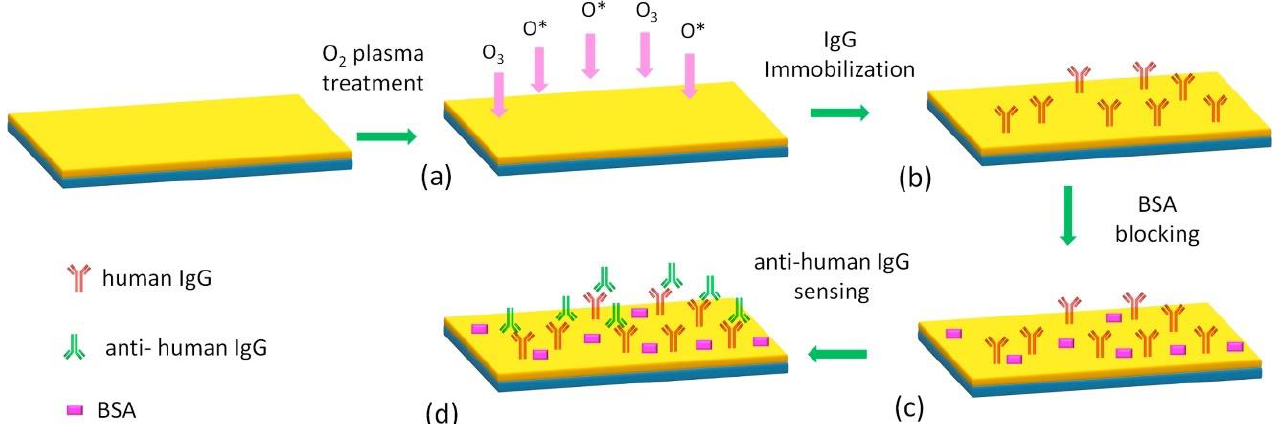
Figure 8. Schematic representation of the immobilization process of IgG on SU-8 substrate and of anti-human IgG binding: ( a ) oxygen plasma treatment for nanotexturing and surface chemical modification of SU-8, ( b ) IgG immobilization on surface, ( c ) blocking with a BSA-based solution, ( d ) incubation of anti-human IgG to evaluate the bioactivity of the immobilized IgG. Reprinted from Grimaldi et al. [53] with permission from Elsevier.